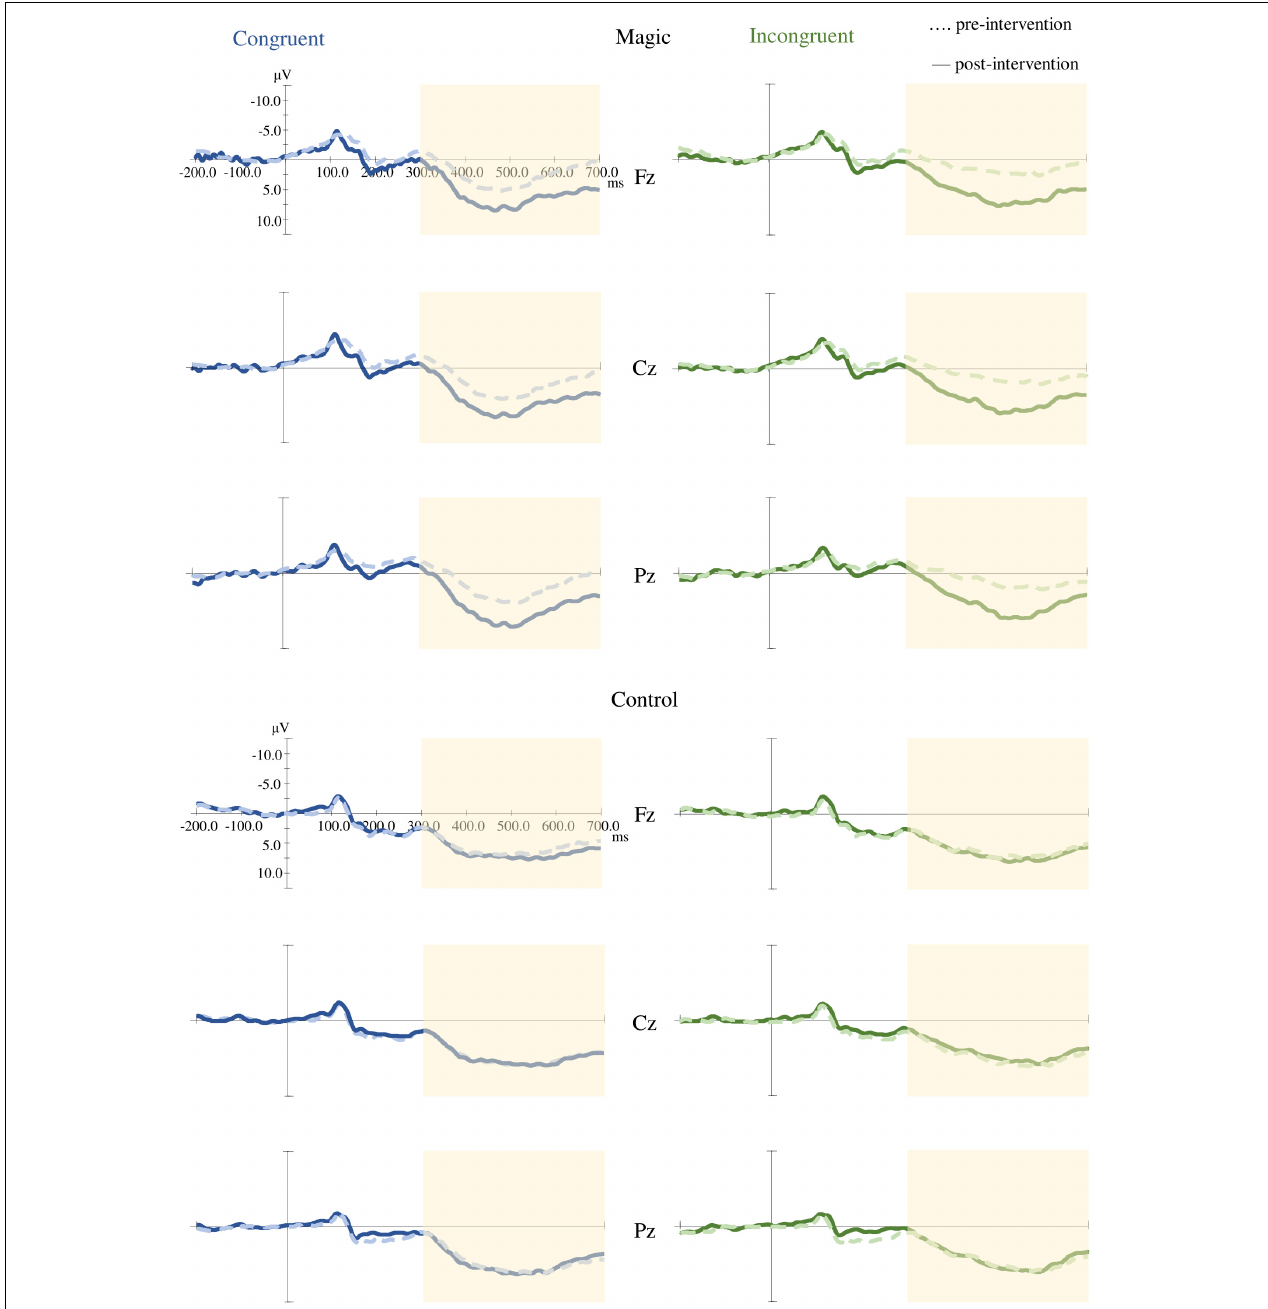
FIGURE 4 | Grand averaged ERP (Fz, Cz, and Pz) under the congruent and incongruent conditions in the magic intervention group before and after the magic intervention program and in the control group before and after the ordinary daily